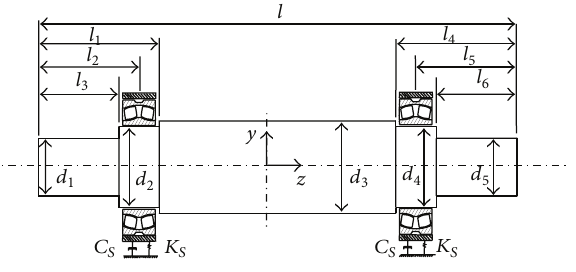
Figure 16: Rigid rotor with two spherical roller bearings [20]. Table 3: Inner ring defect parameters.